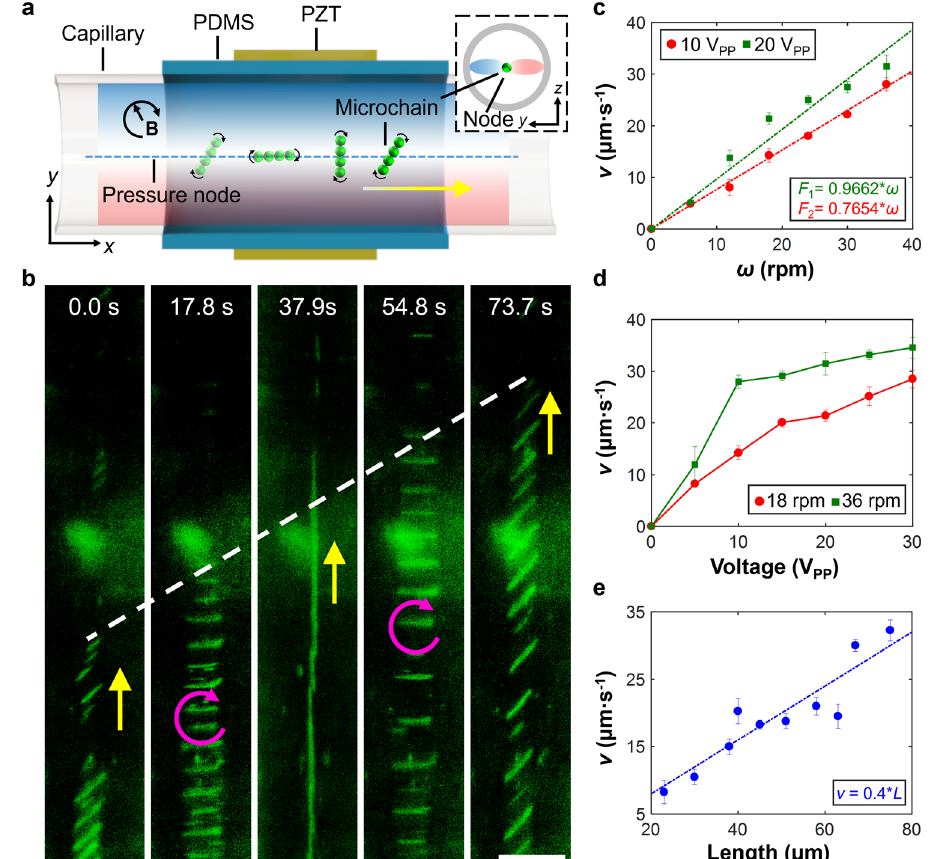
Fig.2|Characterizationofmicrochainsrollingalongthesingleacousticvirtual wall in a con fi ned glass capillary. a Schematic of the experimental setup. The capillary is held by a polydimethylsiloxane (PDMS) polymer substrate with two piezoelectric transducers (PZT) attached on the substrate ’ s lateral surfaces. The inset illustrates a cross-sectional view of the glass capillary with the microchain trapped at the pressurenode of anacousticstanding wave fi eld. b Imagesequence of microchains rolling from bottom to top. The pink curved arrow, yellow arrow, and white dotted line respectively denote the clockwise magnetic rotational direction, net translational direction and displacement. Scale bar, 100 μ m. c